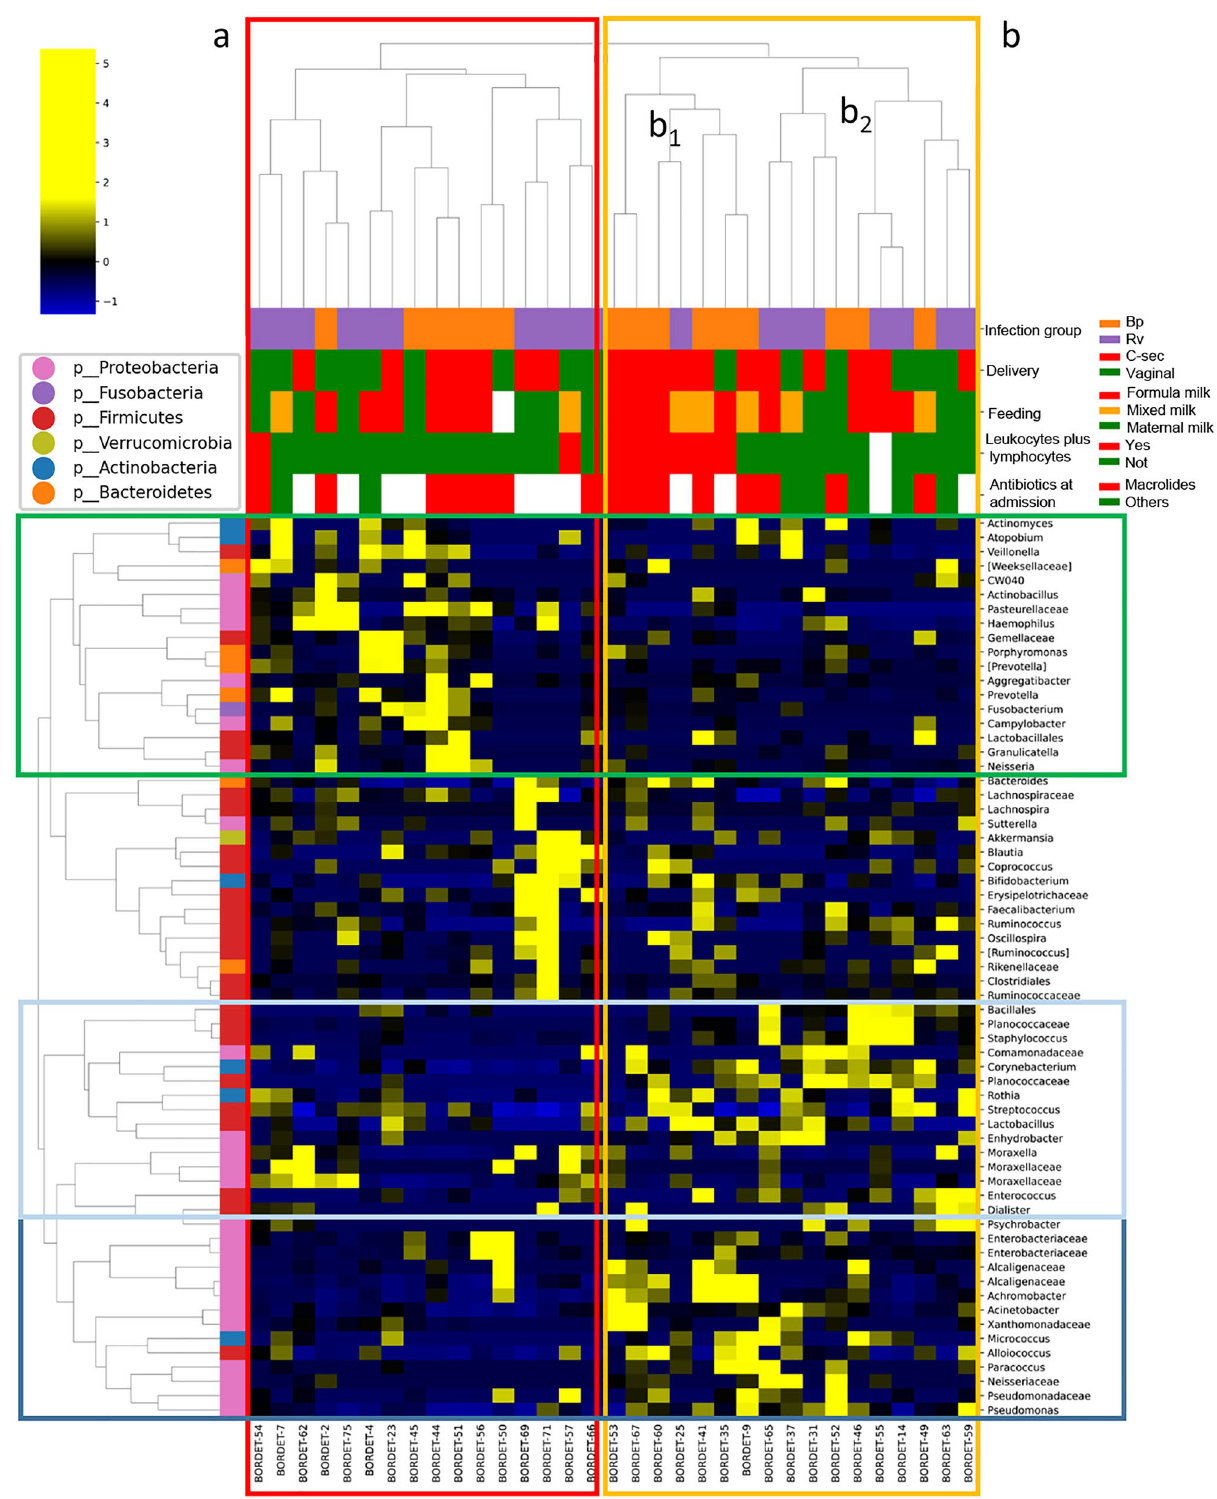
Figure 3. Hierarchical cluster of Bp and Rv patients according to OTU distribution at the genus level. The heat- map reports the hierarchical Ward-linkage clustering based on the Pearson’s correlation coefficient amongst OTUs at genus level. The color scale represents the scaled level of each variable: yellow, high level; blue, low level. The column bar is colored according to the subject category and clinical features’ groups. The left bar is colored according to the phylum level